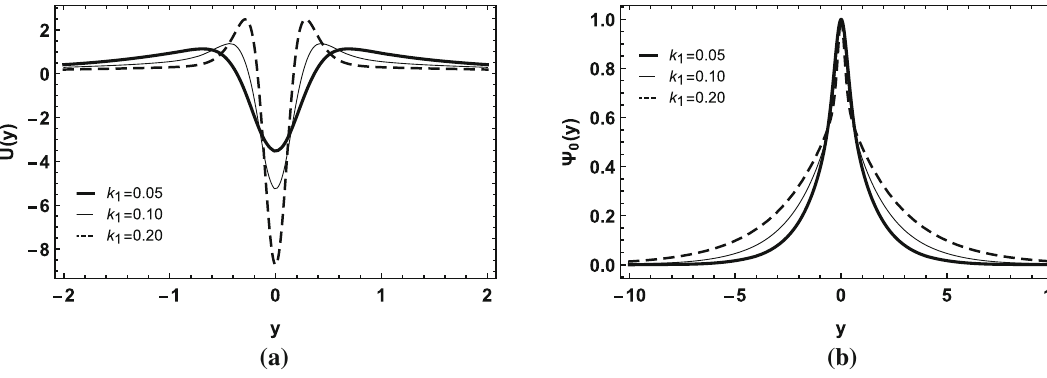
Fig. 12 Plots of the effective potential ( a ), and zero mode ( b ), where k 2 = 0 . 5 and α = β = 1